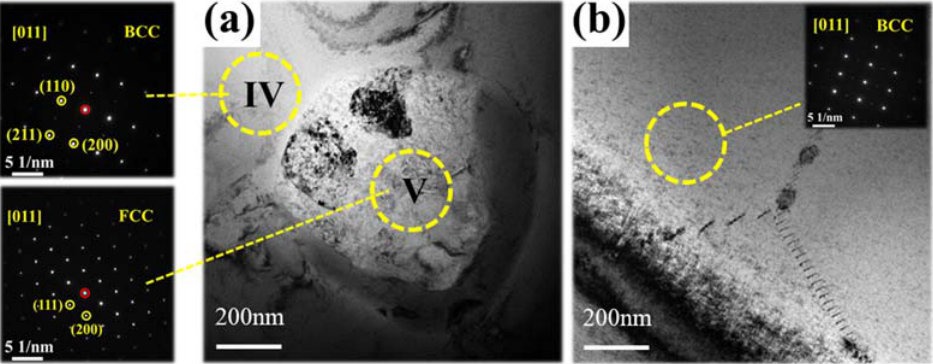
Figure 4. TEM images of Ce5: ( a ) Different regions and corresponding SAED patterns: Region IV: matrix and Region V: Ce ‐ rich region and ( b ) dislocations in the alloy.